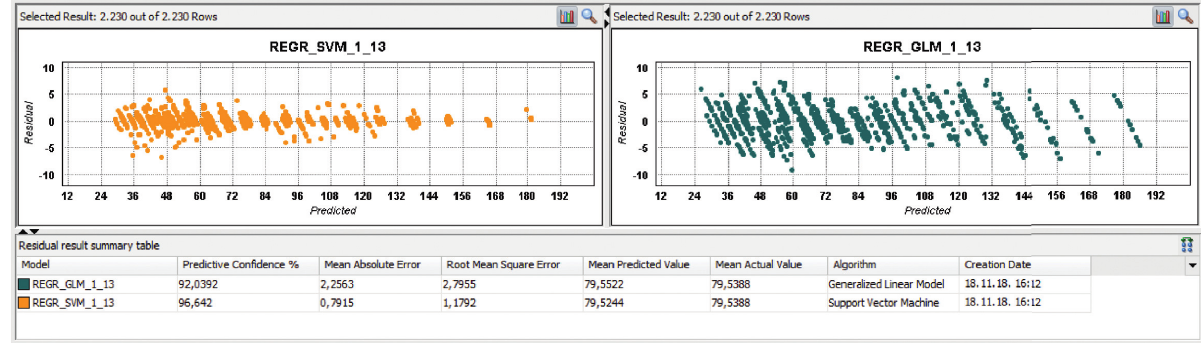
Figure 7: Residual comparison. Table 7: Practical significance of the proposed approach (comparison